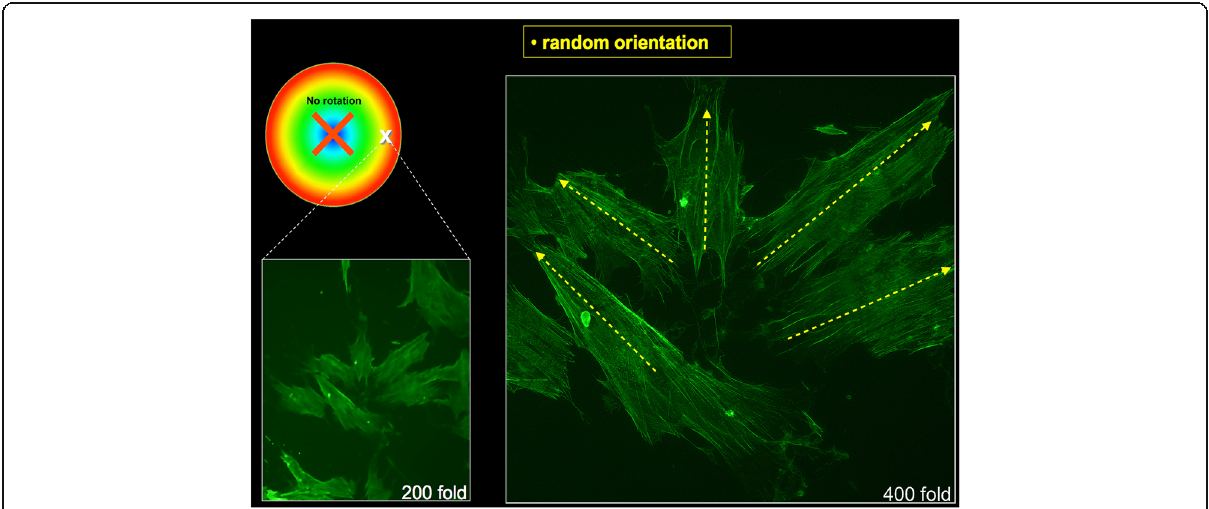
Fig. 4 Randomly orientated osteoblasts without influence of rotation (phallacidin fluorescence staining). On the left side with 200× and on the right side with 400× magnification. The white X on the coloured circle marks the location upon the plate where the osteoblasts were located. The red X marks the centre of the plate